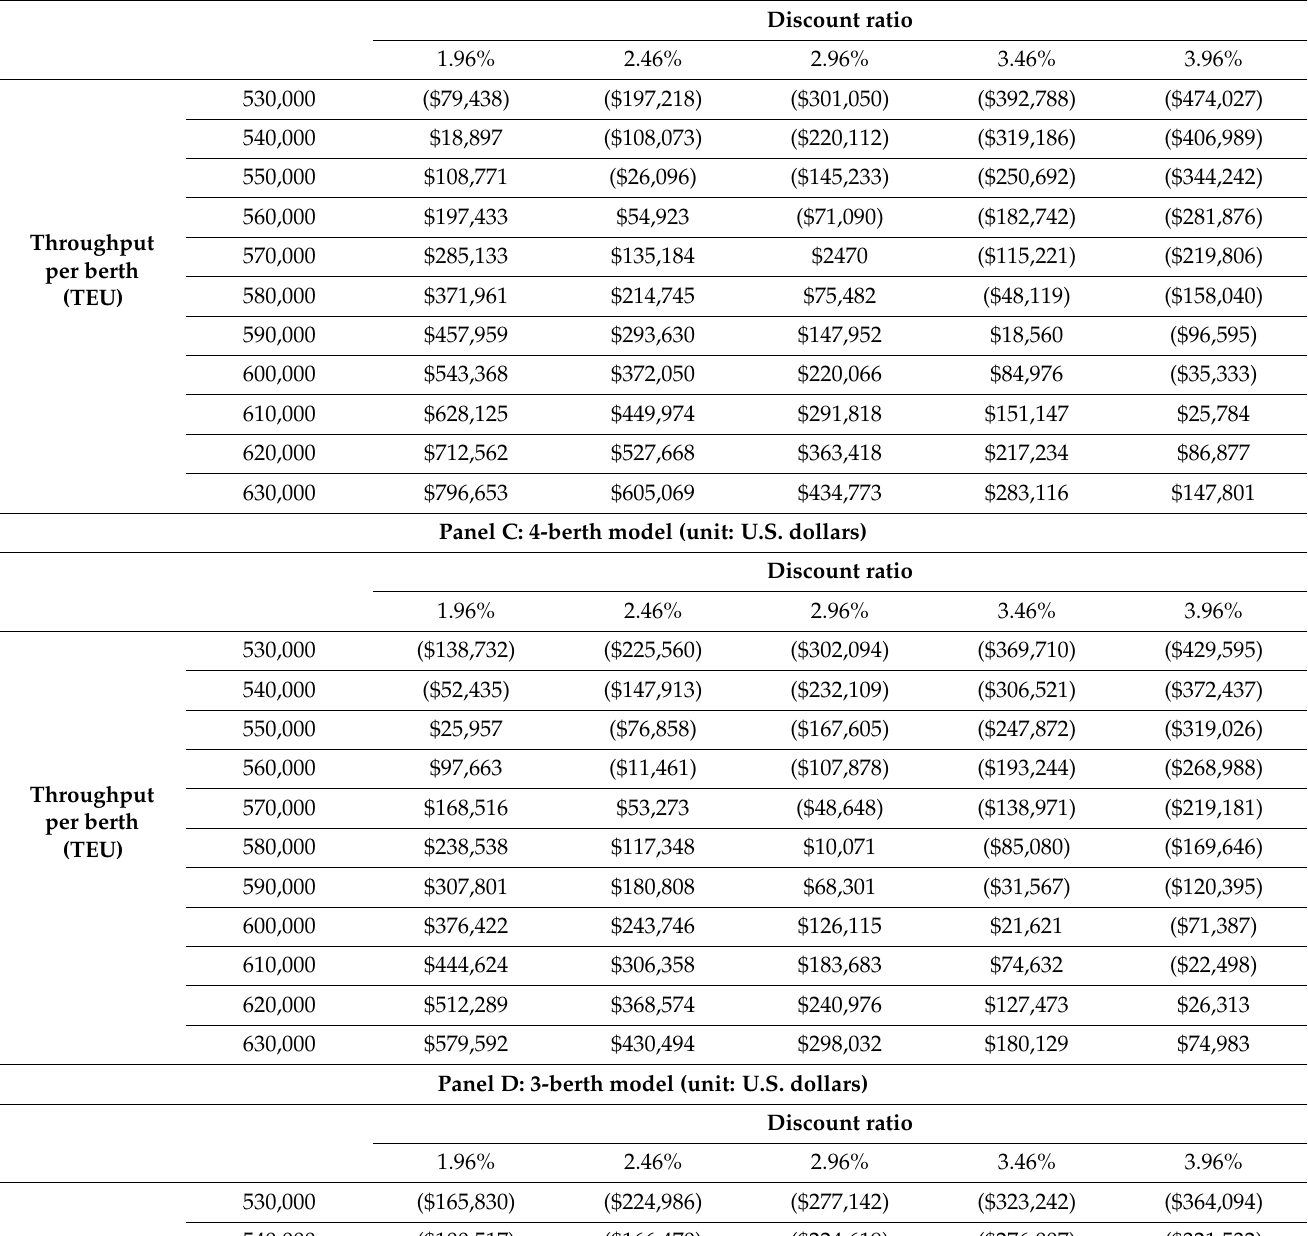
Table A1. Cont. Panel B: 5-berth model (unit: U.S.